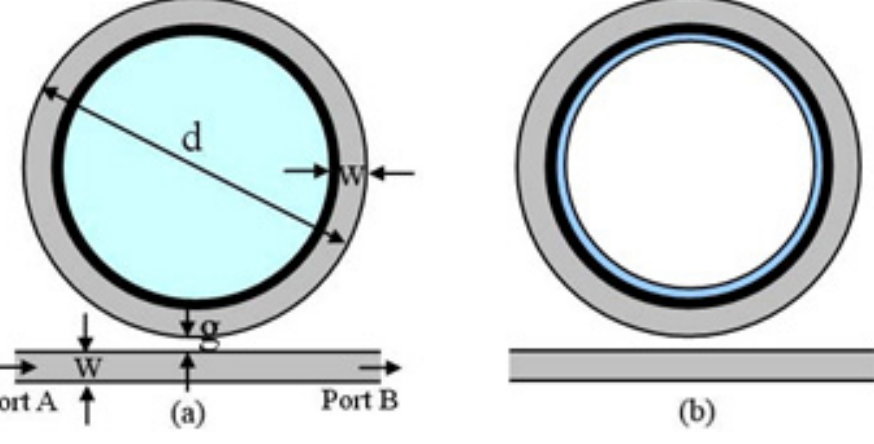
Figure 2. Simulation model of the NPM sensor: (a) homogeneous sensing; (b) surface